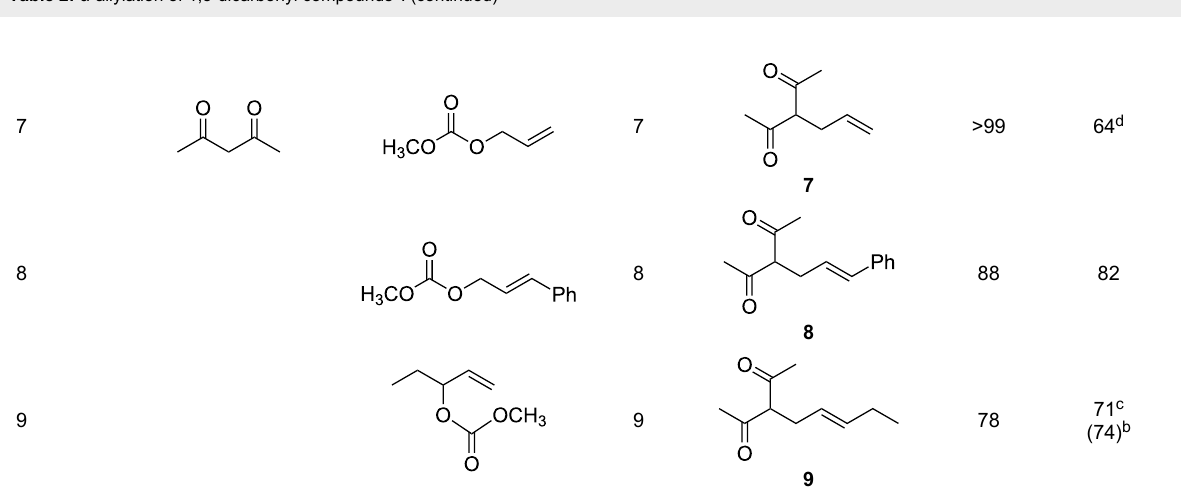
Table 2: α -allylation of 1,3-dicarbonyl compounds a .